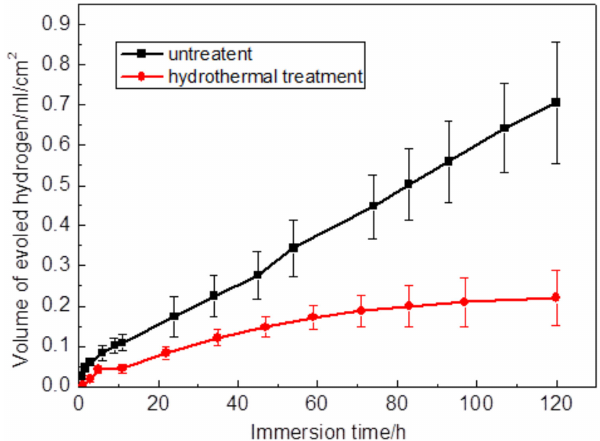
Figure 7. Amount of evolved hydrogen as function of time for HT2 and an untreated sample.